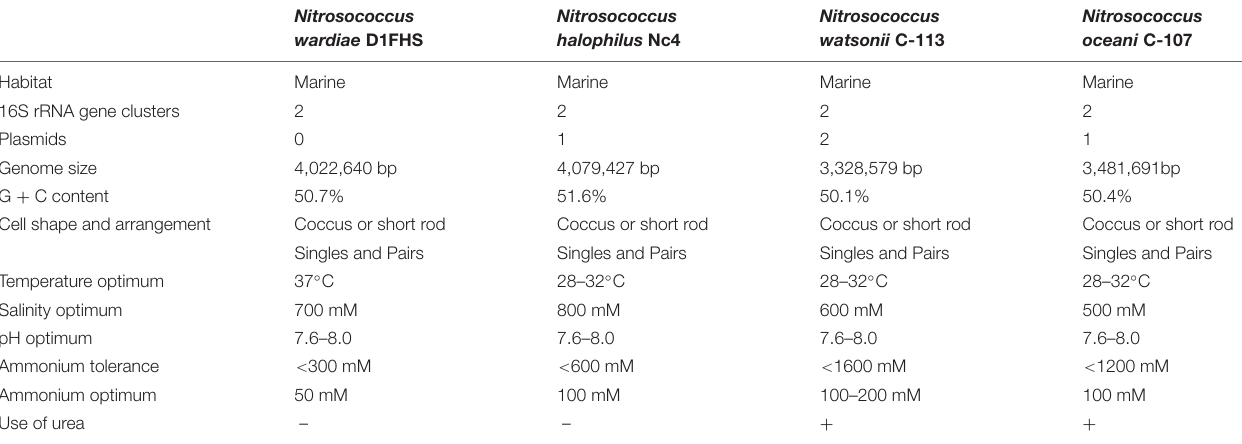
TABLE 5 | Characteristics of Type Strains of species in the genus Nitrosococcus